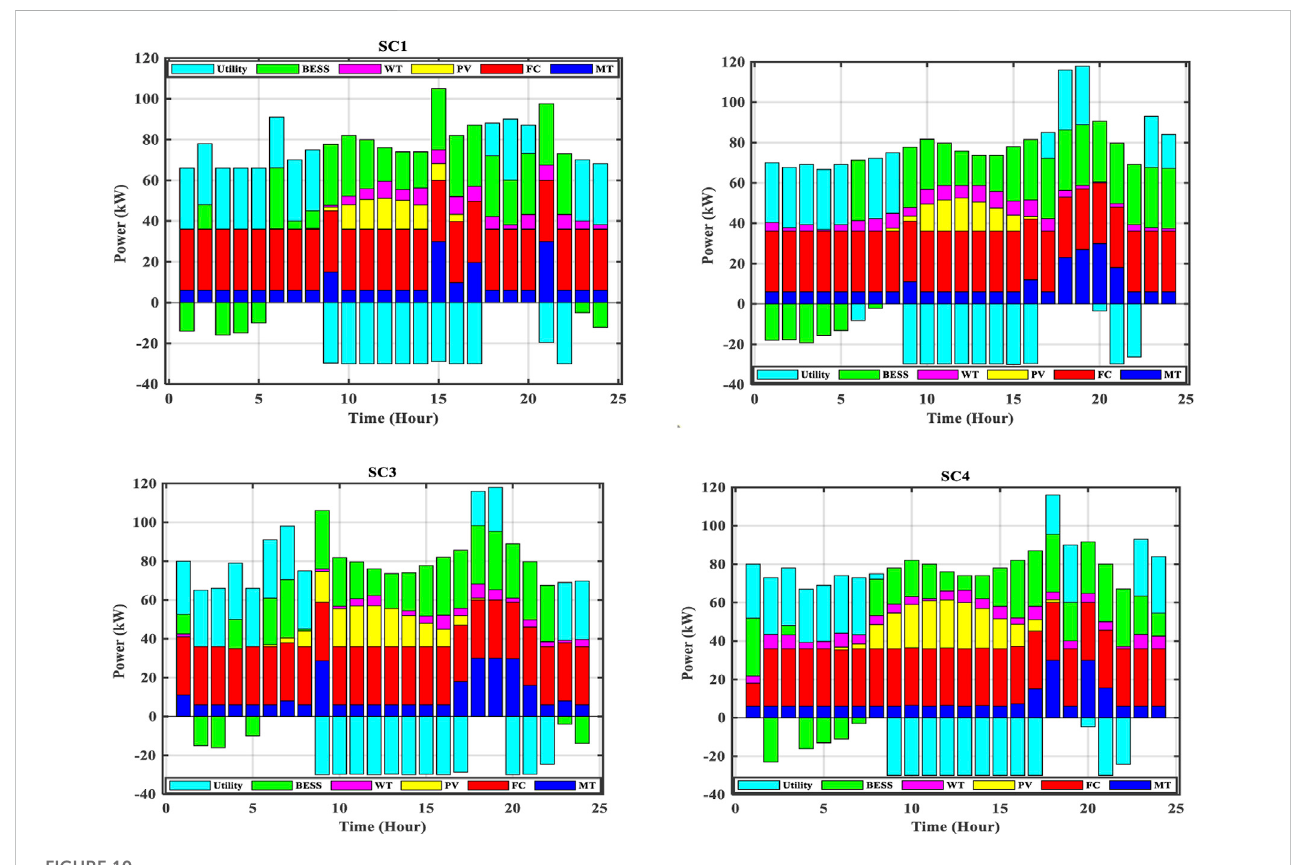
FIGURE 10 Case 20% DSM, SC1, SC2, SC3, SC4.